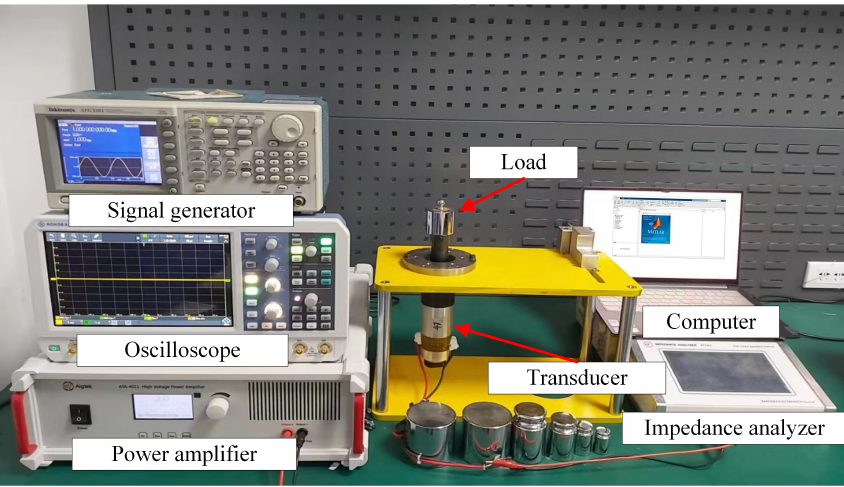
Figure 3. The experiment platform.